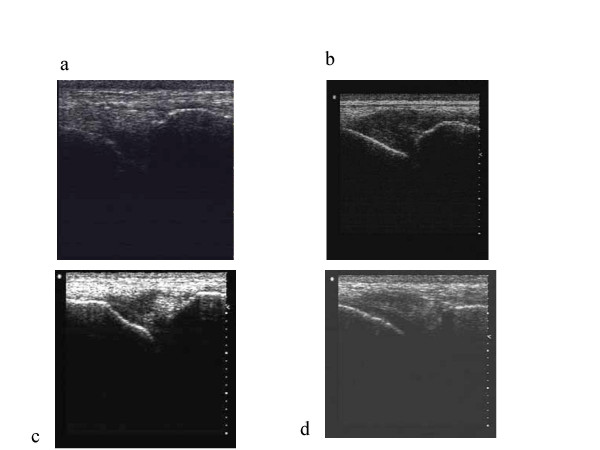
Longitudinal ultrasonograms of the supraspinous ligament. (a) Normal appearance of the supraspinous ligament (b) A representative hypoechogeneic lesion (c) A representative hyperechogeneic lesion (d) A representative alteration of supraspinous ligament fibre pattern.